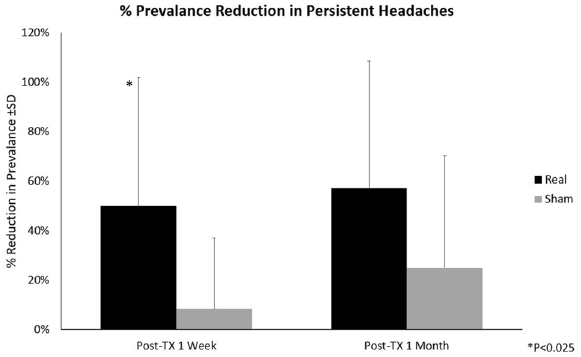
Figure 6. % Reduction in the Prevalence of Persistent Headaches. Pre-Tx: Pre-treatment; Post-Tx: Post- treatment; * P < 0.025. Analysis was conducted using SPSS version